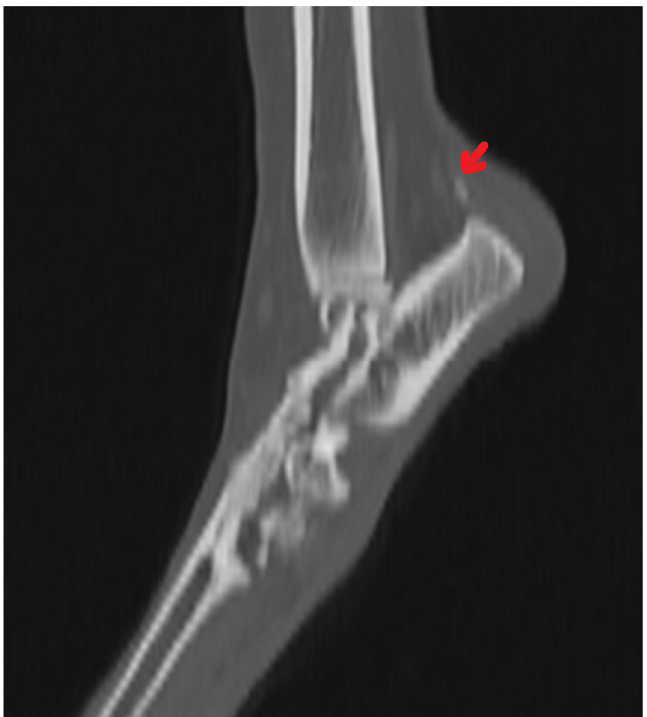
Figure 2. CT image of the mineralization of the Achilles tendon (arrow).